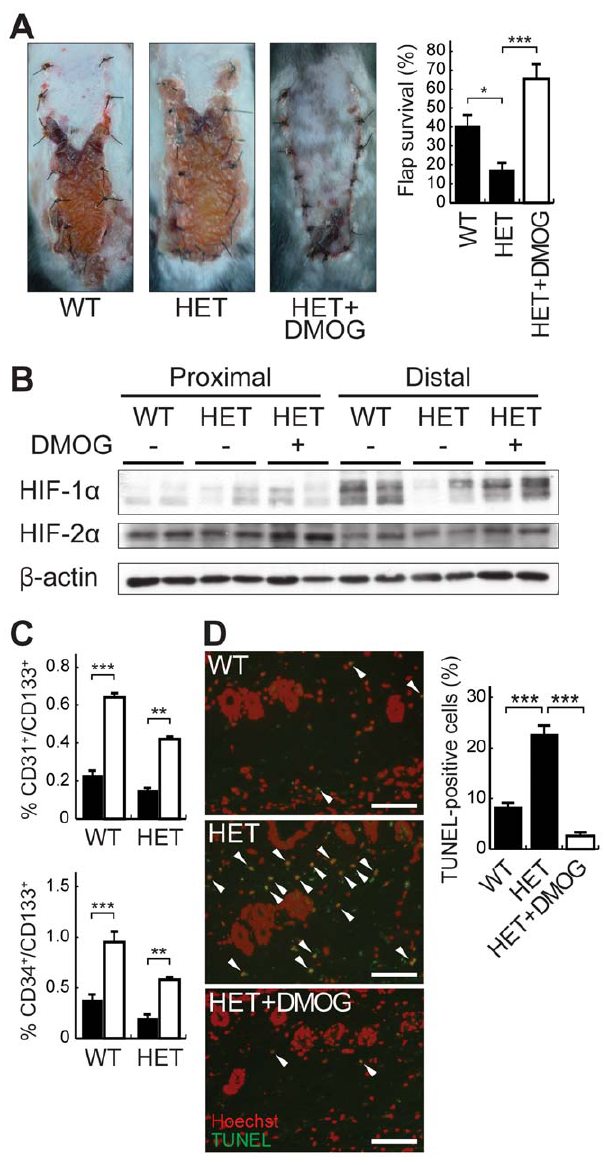
Figure 6. Effects of loss of HIF-1 a function on flap survival. A, Representative ischemic skin flaps from wild-type (WT), heterozygous HIF-1 a deficient (HET), and HET with DMOG pretreatment on postoperative day 7. B, Evaluation of the expression of HIF-1 a and HIF-2 a proteins in the proximal and distal parts of ischemic skin flaps on postoperative day 1. C, Measurement of EPCs in peripheral blood on postoperative day 1. DMOG pretreatment increased the numbers of EPCs in both WT and HET mice. The percentage of the peripheral blood cells constituted by the EPC population was measured as the percentage of CD45 + -gated cells positive for the indicated cell surface markers by flow cytometry. D, The apoptotic cells in the distal parts of the skin flaps taken from WT and HET mice with or without DMOG pretreatment on postoperative day 1 were detected by TUNEL staining. Sections of the skin flaps were stained for TUNEL (green) and Hoechst (red). The ratio of TUNEL-positive cells to cell nuclei in the sections was calculated. Values are means 6 SEM. * P , 0.05, ** P , 0.01, *** P , 0.001. Scale bar indicates 50 m m.